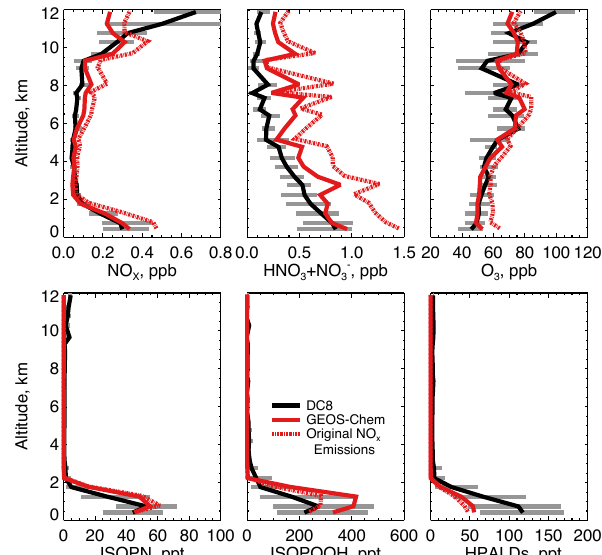
Figure 2. Median vertical concentration profiles of NO x , total in- ) , ozone, isoprene nitrate organic nitrate (gas HNO 3 + aerosol NO − 3 (ISOPN), isoprene hydroperoxide (ISOPOOH), and hydroperoxy- aldehydes (HPALD) for the SEAC 4 RS flights over the Southeast US (domain of Fig. 1). Observations from the DC-8 aircraft are compared to GEOS-Chem model results. The dashed red line shows model results before adjustment of NO x emissions from fuel com- bustion and lightning (see text). The 25th and 75th percentiles of the DC-8 observations are shown as grey bars. The SEAC 4 RS observa- tions have been filtered to remove open fire plumes, stratospheric air, and urban plumes as described in the text. Model results are sampled along the flight tracks at the time of flights and gridded to the model resolution. Profiles are binned to the nearest 0.5km. The NOAA NO y O 3 four-channel chemiluminescence (CL) instrument made measurements of ozone and NO y (Ryerson et al., 1998), NO (Ryerson et al., 2000), and NO 2 (Pollack et al., 2010). Total inor- ganic nitrate was measured by the University of New Hampshire Soluble Acidic Gases and Aerosol (UNH SAGA) instrument (Dibb et al., 2003) and was mainly gas-phase HNO 3 for the SEAC 4 RS conditions. ISOPOOH, ISOPN, and HPALDs were measured by the Caltech single mass analyzer CIMS (Crounse et al., 2006; Paulot et al., 2009a; Crounse et al.,